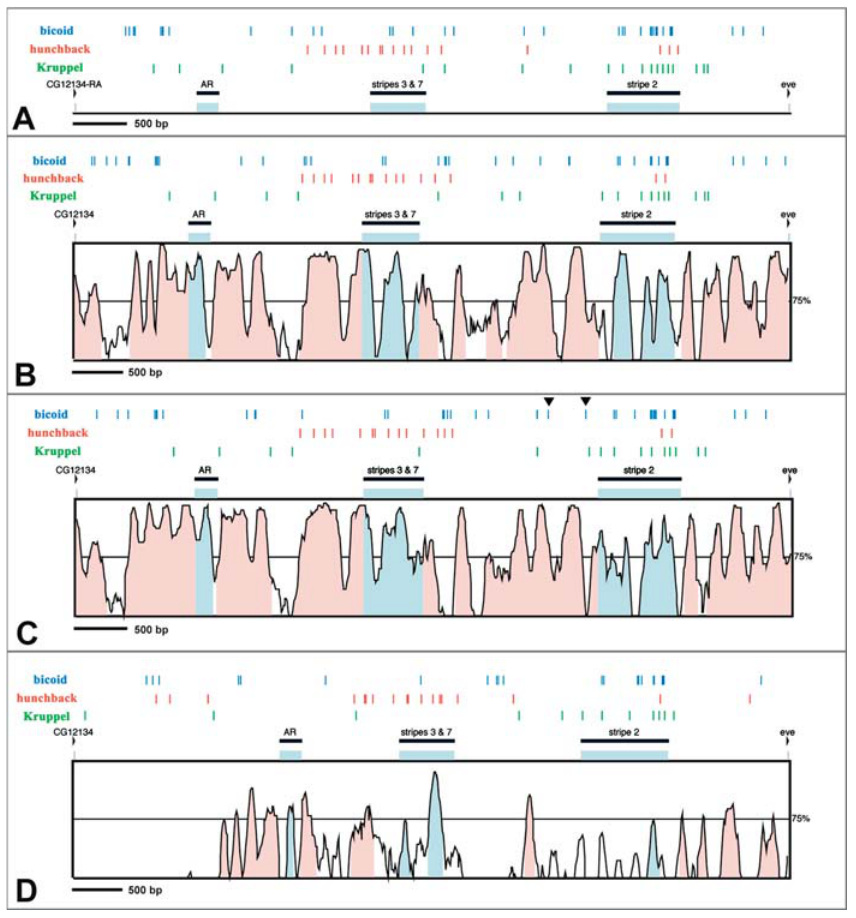
Figure 7. Predicted Binding-Site Composition and Sequence Conservation in the eve 5 9 Noncoding Region (A) D. melanogaster predicted binding-site composition. (B) D. yakuba predicted binding-site composition and sequence conservation with D. melanogaster. (C) D. erecta predicted binding-site composition and sequence conservation with D. melanogaster. (D) D. pseudoobscura predicted binding-site composition and sequence conservation with D. melanogaster. Coordinates of functionally characterized enhancer sequences are shown in light blue, and unannotated conserved noncoding sequences are shown in pink. The coordinates of the homologous stripe 2 sequences correspond to the constructs in Figure S1, while the coordinates of the AR and stripe 3 enhancers have been estimated based on sequence conservation. Note that the scale of the genomic intervals plotted differs between panels (black bar = 500 bp). Binding sites are indicated by color; bicoid (blue), hunchback (red), and Kruppel